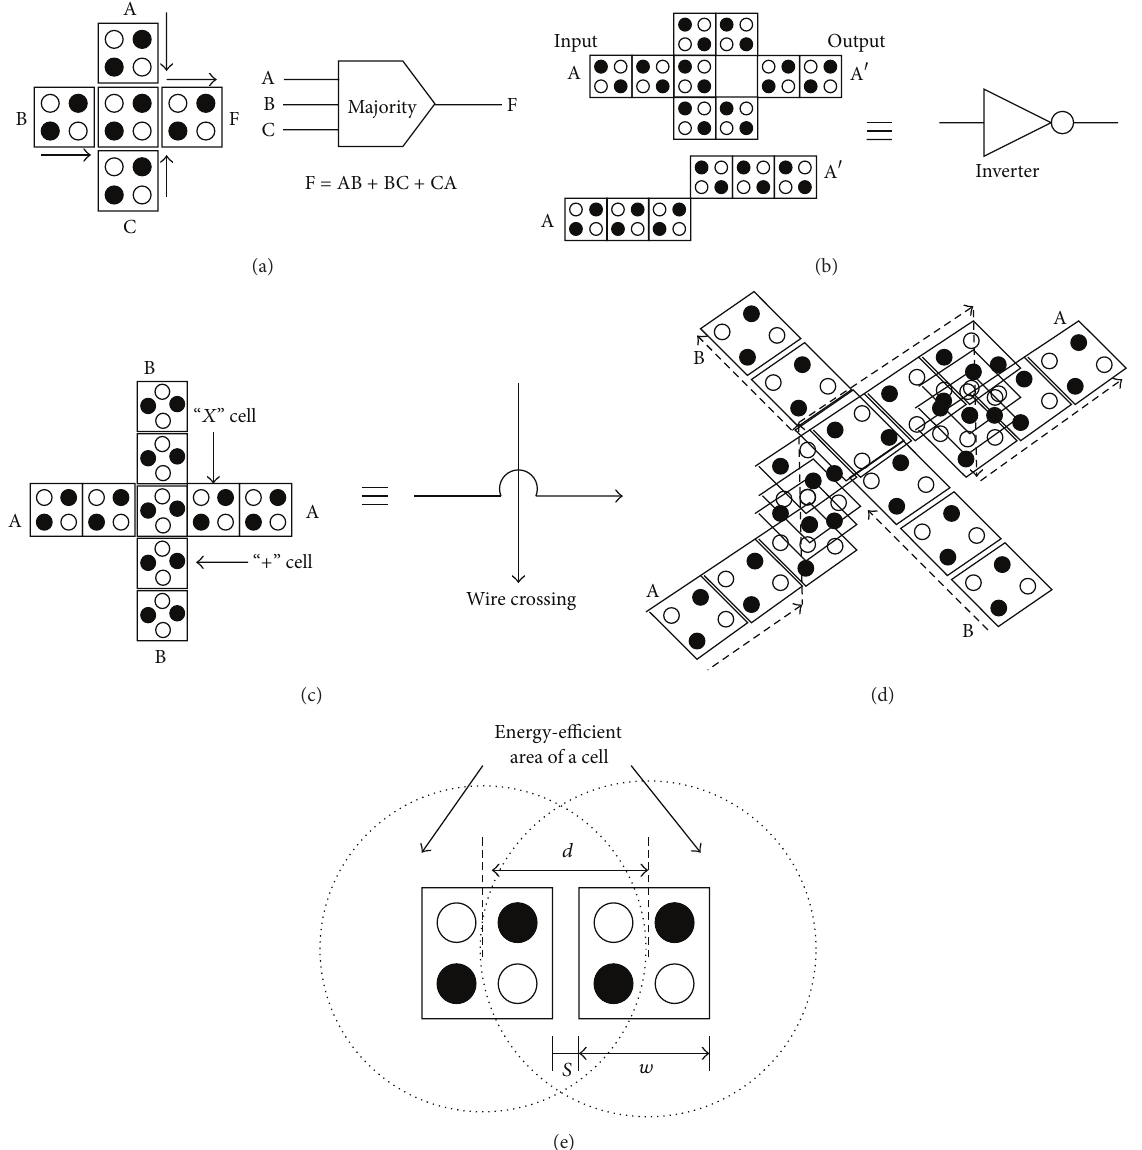
Figure 2: (a) Majority voter, (b) inverter, (c) coplanar wire crossing, (d) multilayer wire crossing, and (e) area under induced effect of majority